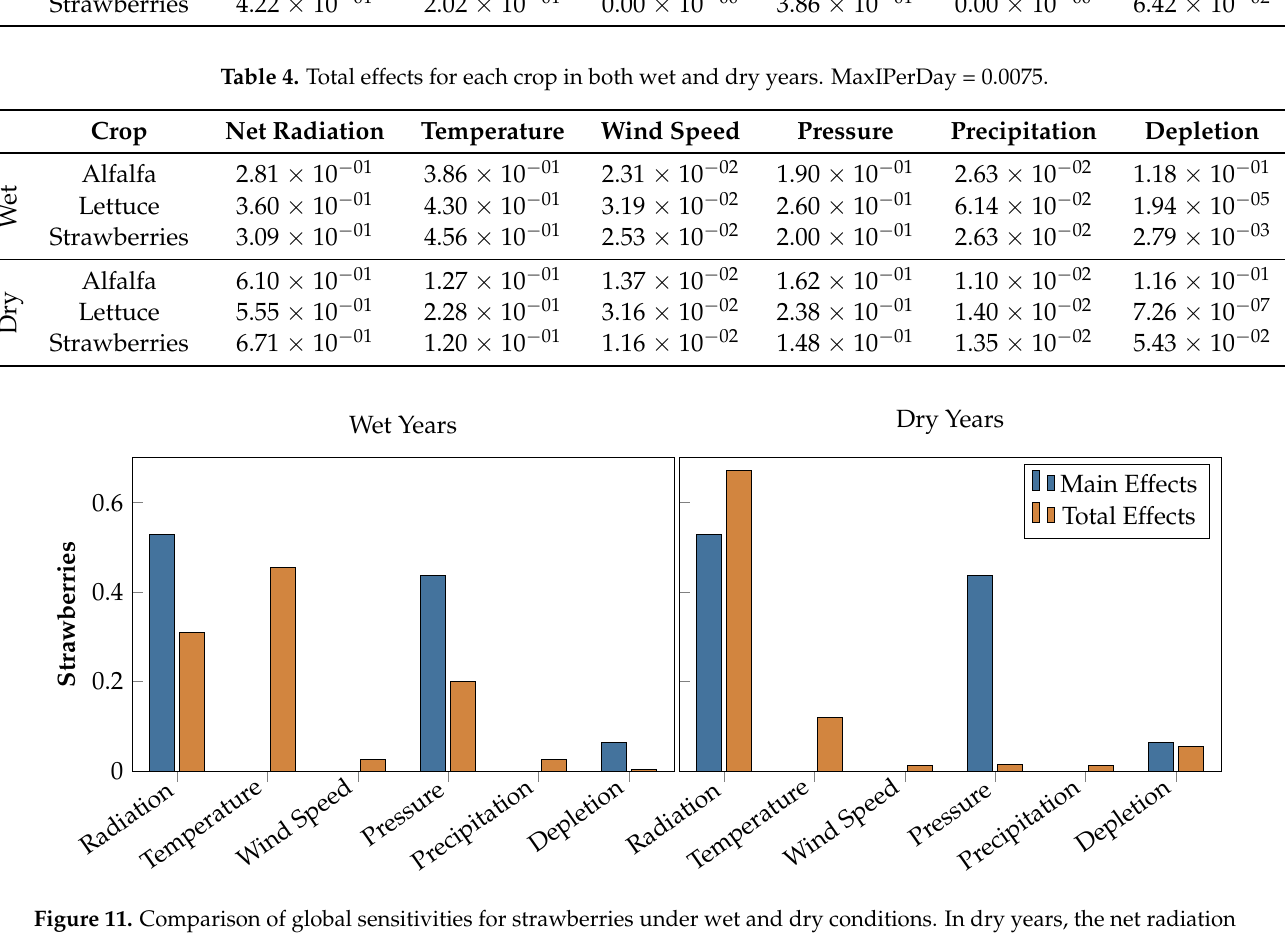
Figure 11. Comparison of global sensitivities for strawberries under wet and dry conditions. In dry years, the net radiation contributes more to uncertainty in yield predictions than it does in wet years. As shown in the total effects, the temperature has a smaller relative impact on the yield in dry years. Sensitivities for other crops can be found in Tables 3 and